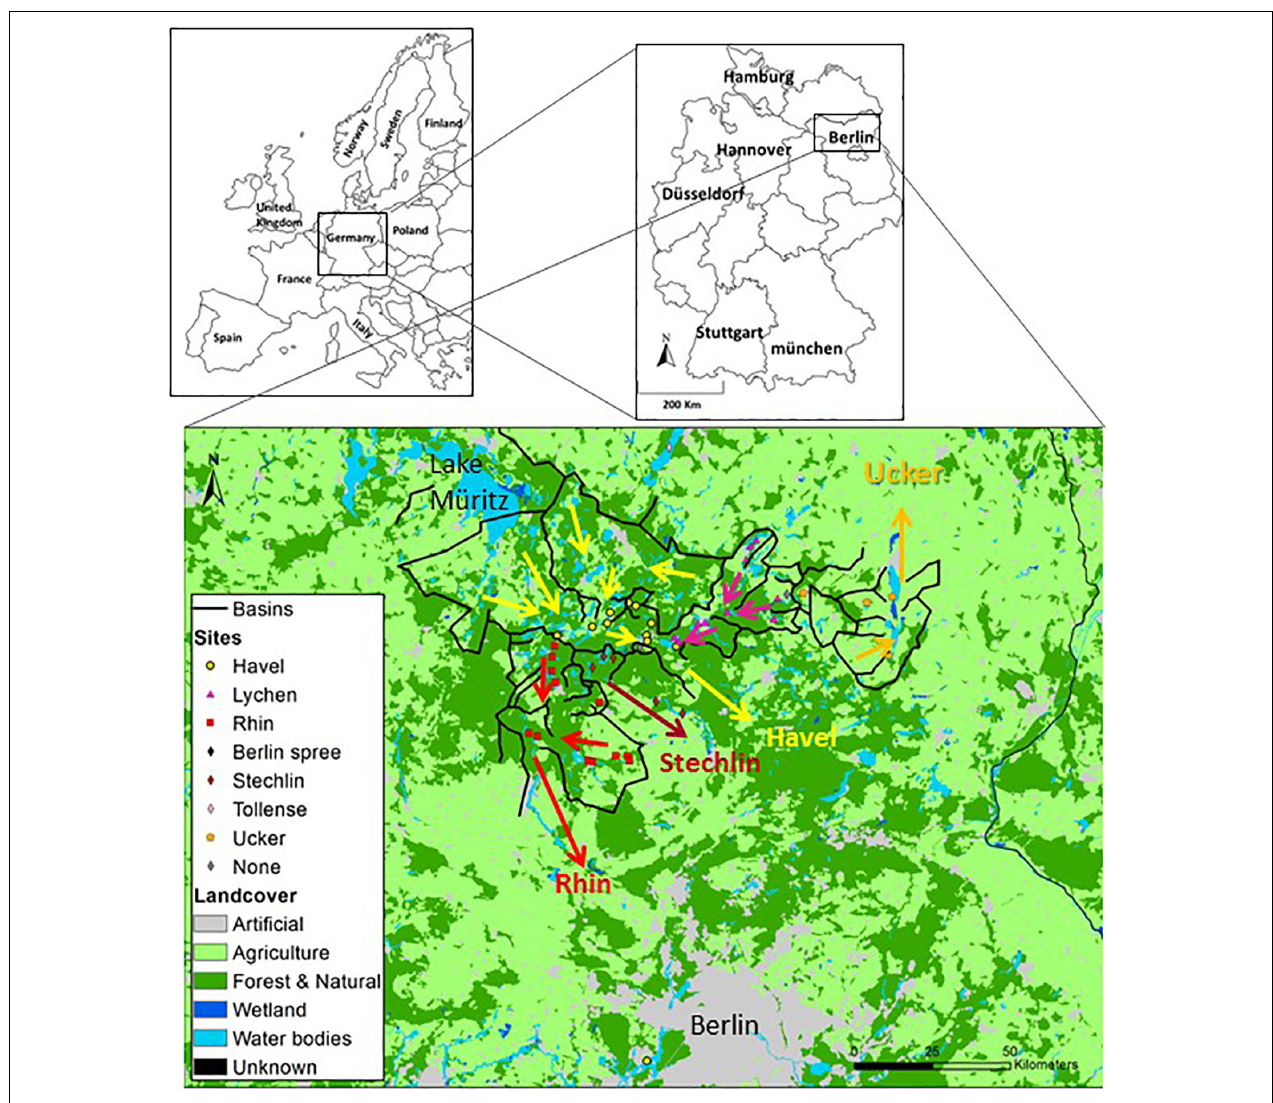
FIGURE 1 | Land use and drainage basins in the sampling area. A total of 46 samples were collected from lakes and a fish-pond in the Brandenburg region of northern Germany. Five types of land use: urban areas, agriculture (further divided for GLM analysis to heterogeneous agriculture, pasture lands and arable lands), forests, wetlands and water bodies, were mapped using GIS. Superimposed black lines connect topographically high points and indicate the borders of the drainage basins and of major sub-basins. The arrows indicates the dominant flow direction within each basin. A map with the identities of each sampling location is presented in Supplementary Figure 1 , and the detailed information on each sampling location can be found in Supplementary Data File 1